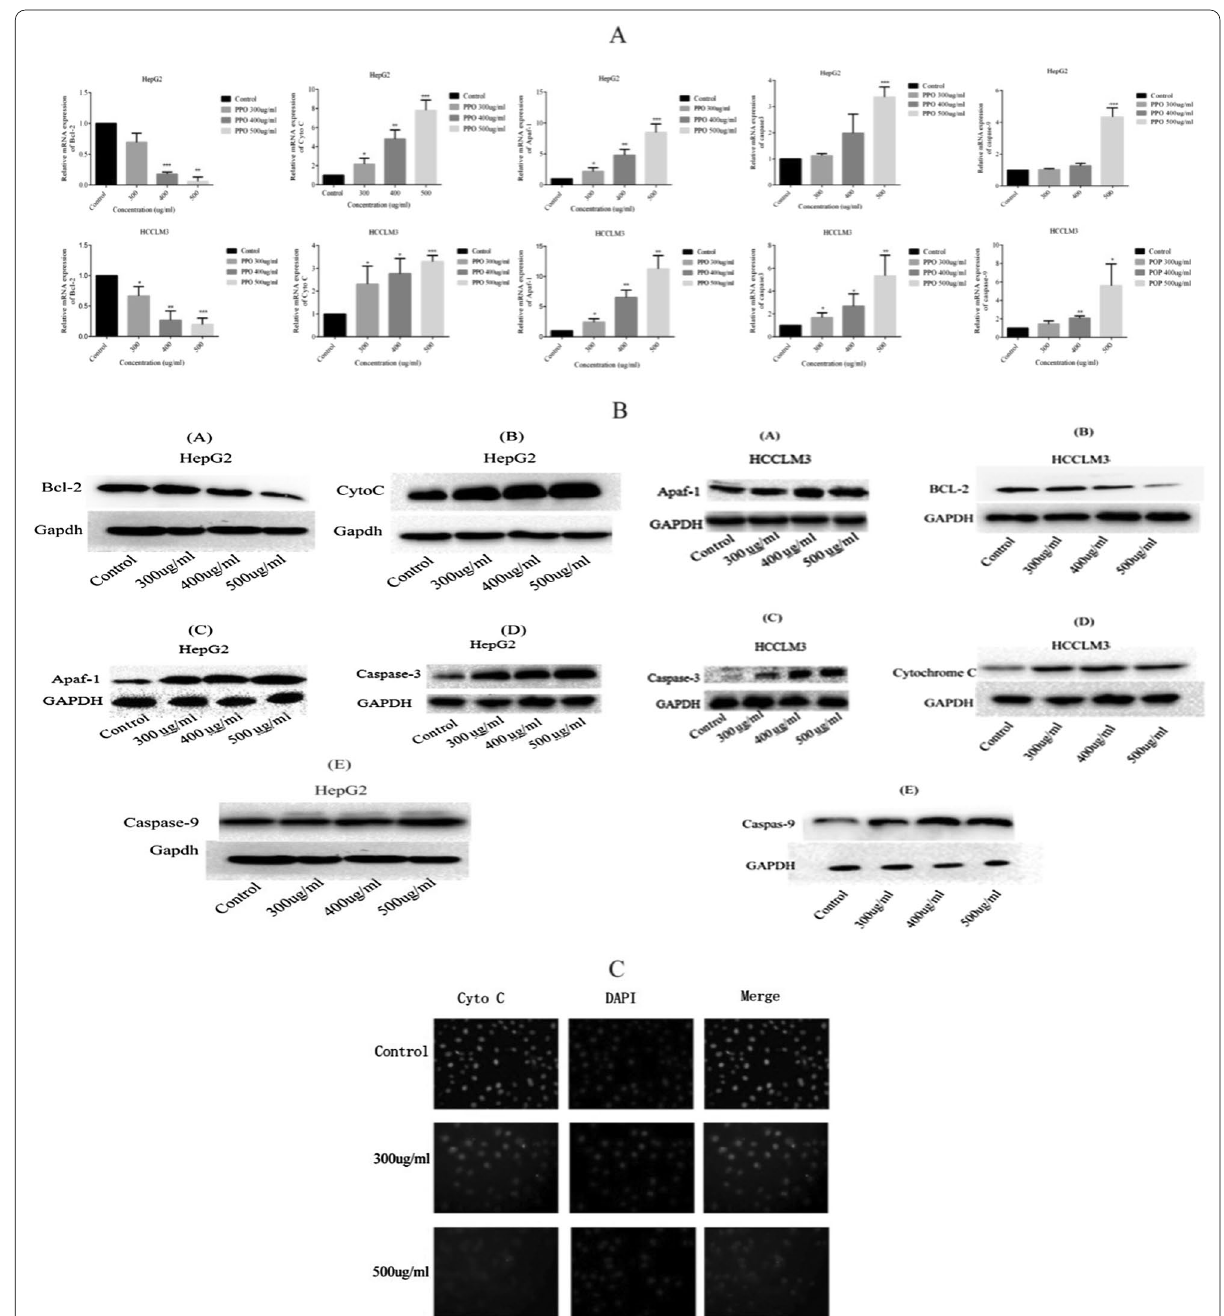
Fig. 6 Gene expression of genes involved in cell death was quantified A qPCR was performed to observe gene expression of five different genes in both HepG2 and HCCLM3. B Western blot assay was performed to observe the expression of five genes including BCL-2, Cytochrome c, Apaf-1, Caspase-9, and Caspase-3. C Immunofluorescence assay was performed to observe gene expression of Cytochrome c as it was supposed to be the initiator of apoptosis. *p < 0.05, **p < 0.01, ***p 0.001. *PPO (Polysaccharide from Pleurotus ostreatus ), *CTX ≤